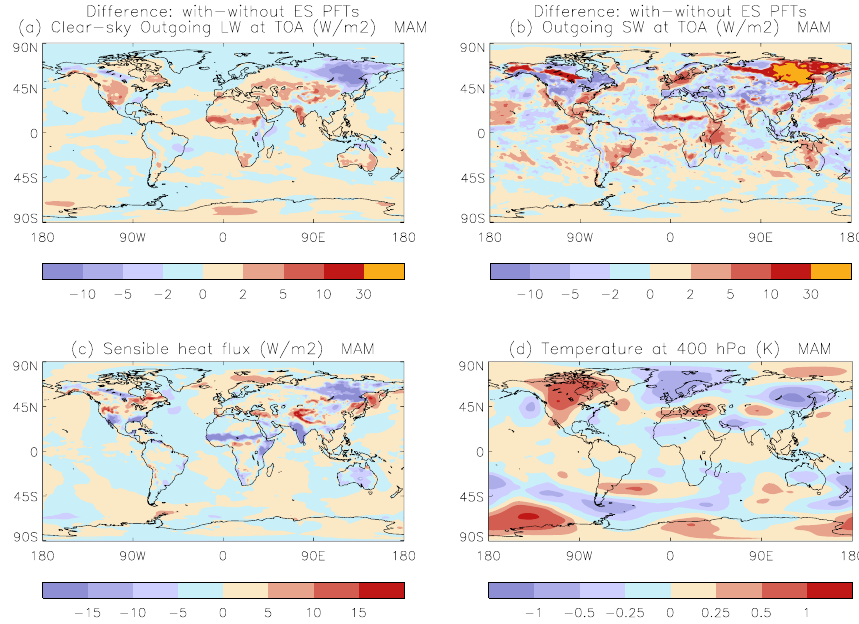
Fig. 10. Global changes in March, April, May (MAM) between experiments with and without land cover from HadGEM2-ES, and with no dust radiative effects: (a) clear-sky outgoing longwave radiation at top-of-atmosphere (TOA); (b) outgoing shortwave radiation at TOA; (c) surface sensible heat flux; (d) temperature at 400hPa.